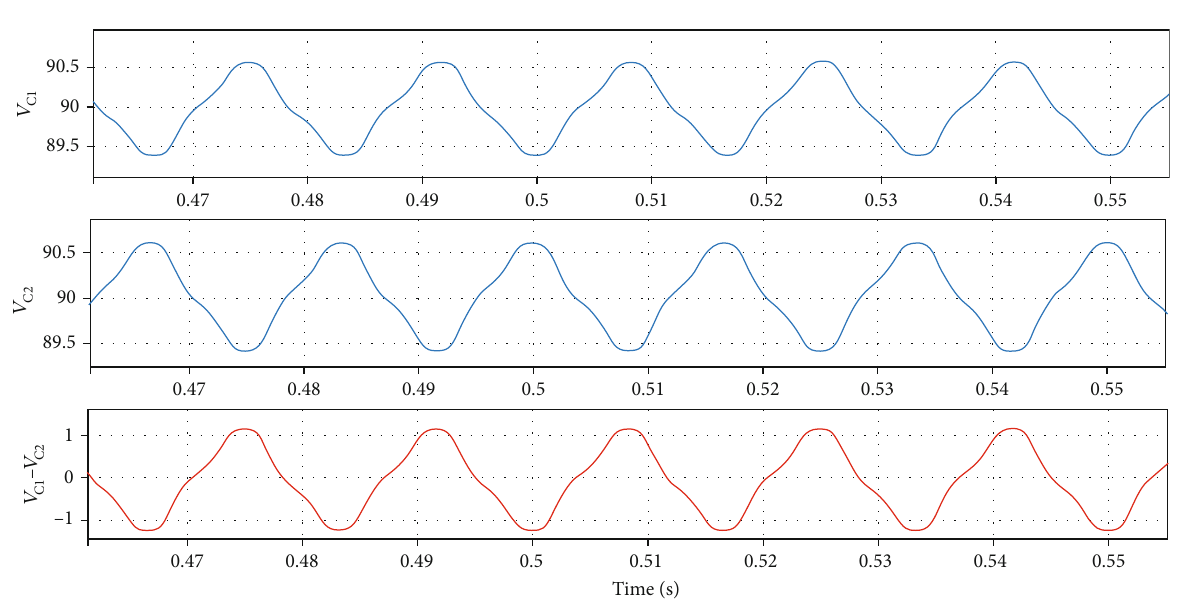
Figure 3: SVPWM switching mode of Γ u inverter.